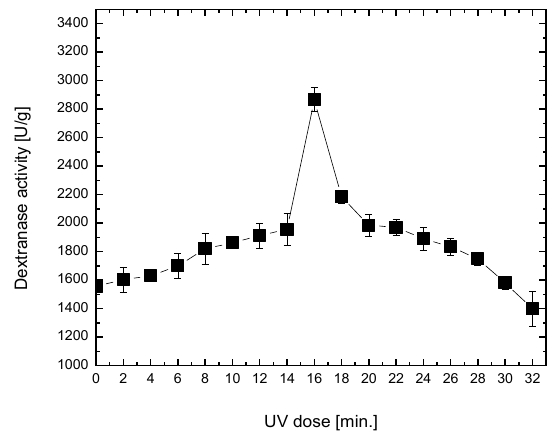
Figure 8. Effect of UV irradiation (min.) on the activity of